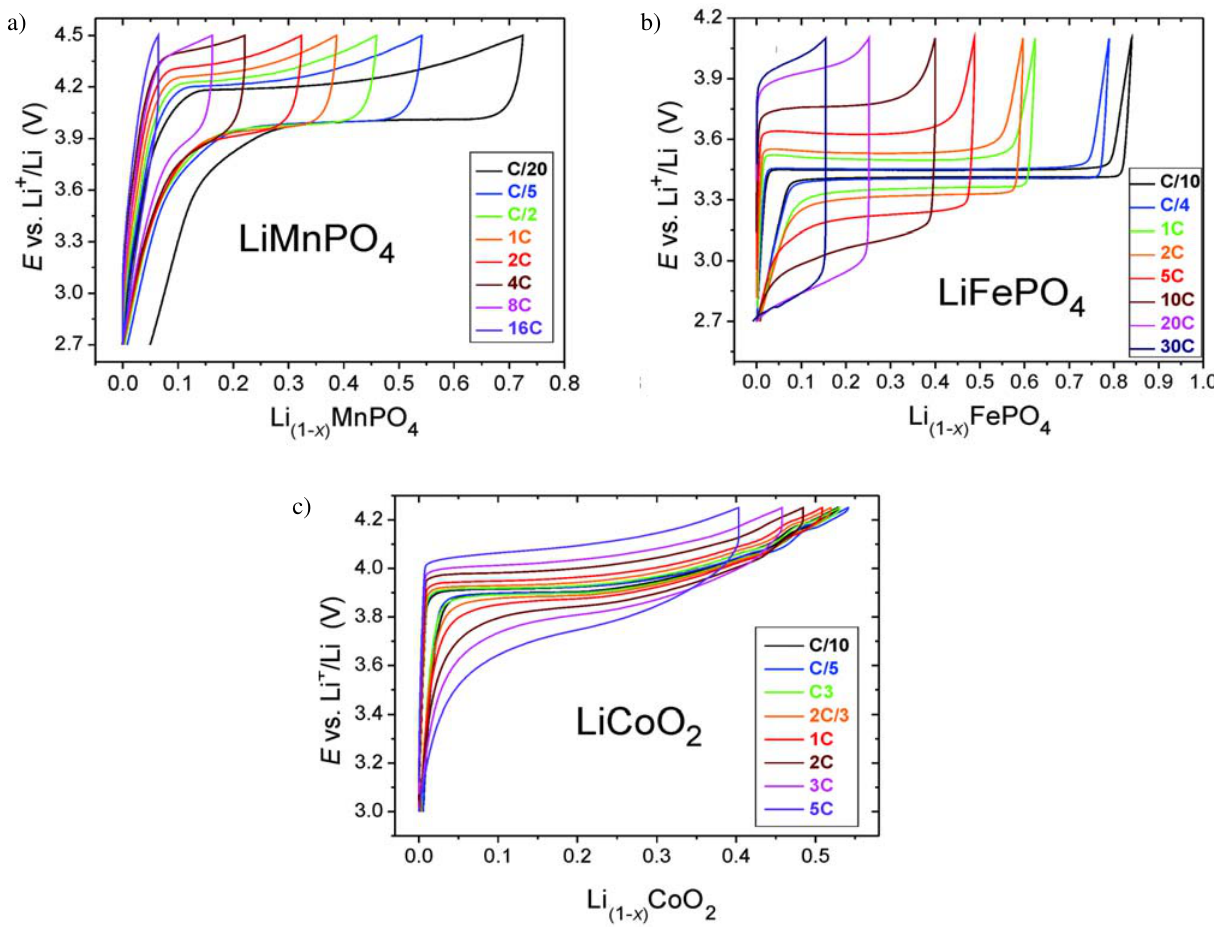
(from C/20 up to 4 (from 2